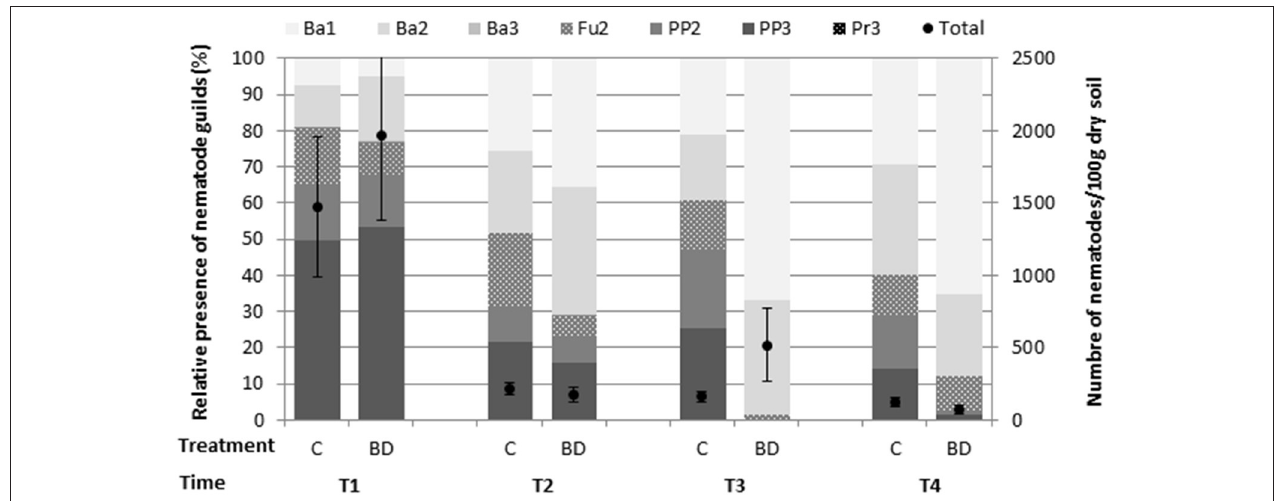
FIGURE 6 | Percentage of relative presence of different nematode guilds are represented by bar chart: Ba1 (bacterivores cp-1), Ba2 (bacterivores cp-2), Ba3 (bacterivores cp-3), Fu2 (fungivores cp-2), PP2 (plant-parasitic cp-2), PP3 (plant-parasitic cp-3) and Pr3 (predators cp-3). Total number of nematodes presented in 100g of soil (dry matter) is represented by dot chart with the standard errors. Values of soil samples collected in the biodisinfested (BD) and control (C) soils at four different times: T1 (pre-treatment), T2 (post-treatment), T3 (post-crop after treatment) and T4 (1 year after